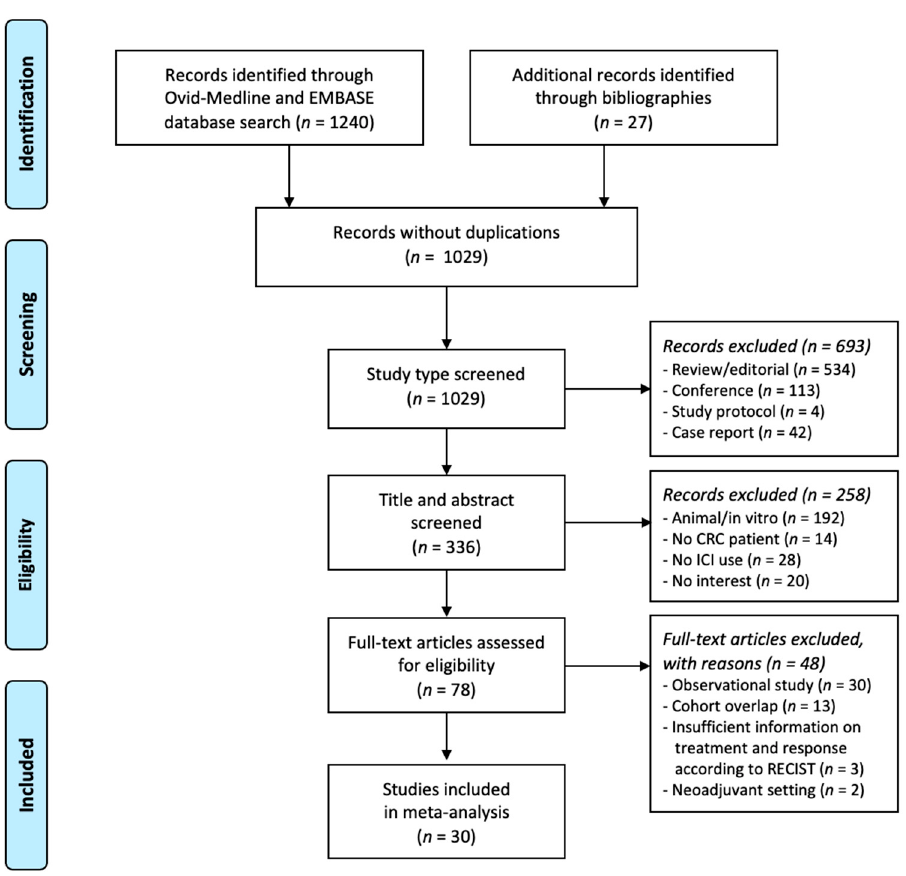
Figure 1. Flow diagram of the study selection process. RECIST, Response Evaluation Criteria for Solid Tumors.